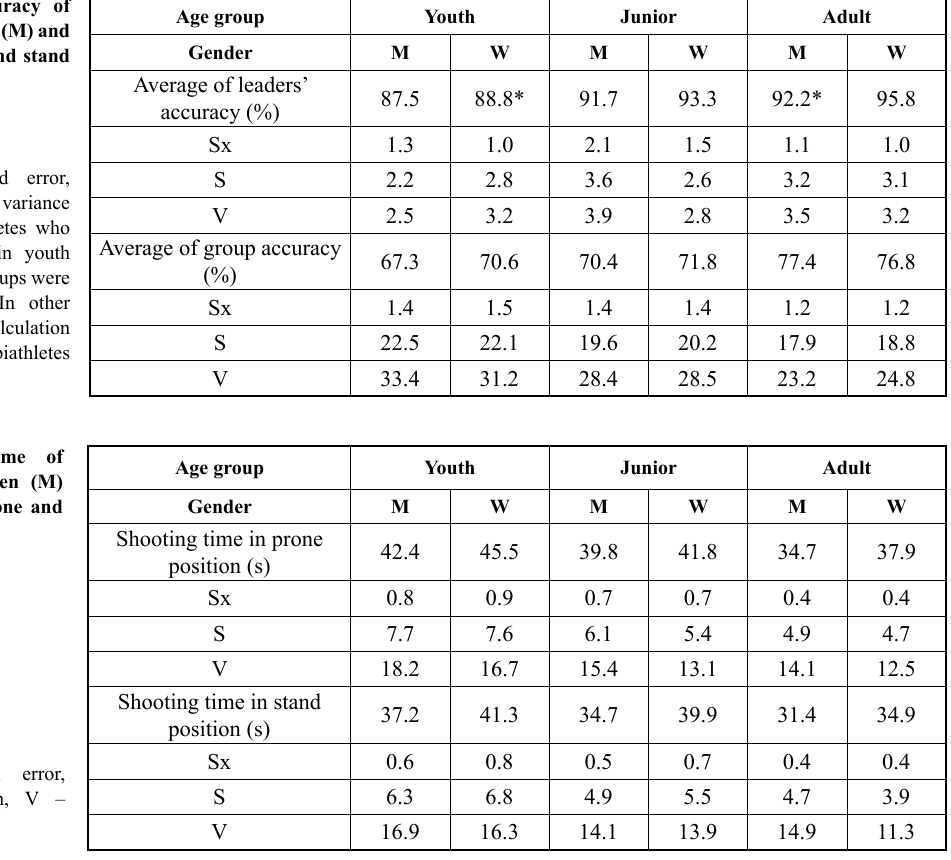
Table 1. Shooting accuracy of various age groups, men (M) and women (W), in prone and stand positions